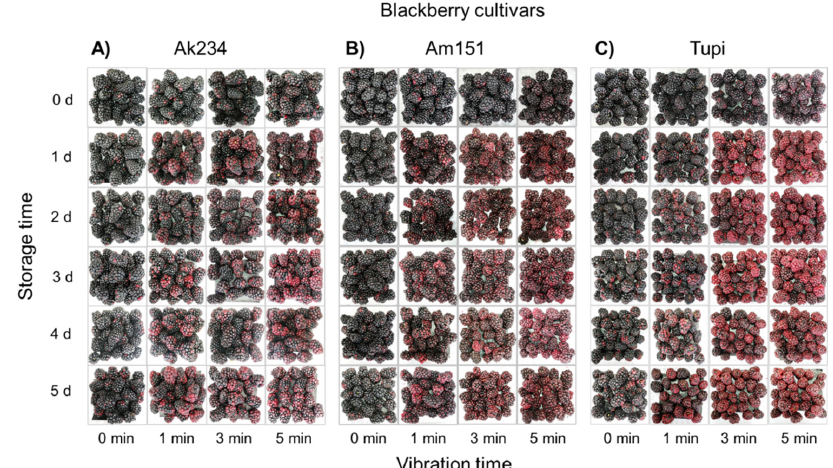
Figure 3. Vibration produces by the portable vibrator system induces RDR in different blackberry fruit cultivars. Color changes in ( A ) ‘Ak234 ′ , ( B ) ‘Am151 ′ , and ( C ) ‘Tupi’ cultivars induced by different vibration (10 Hz and 0.5 g’ s) times (0, 1, 3, and 5 min) during 5 d of storage at 1 °C.